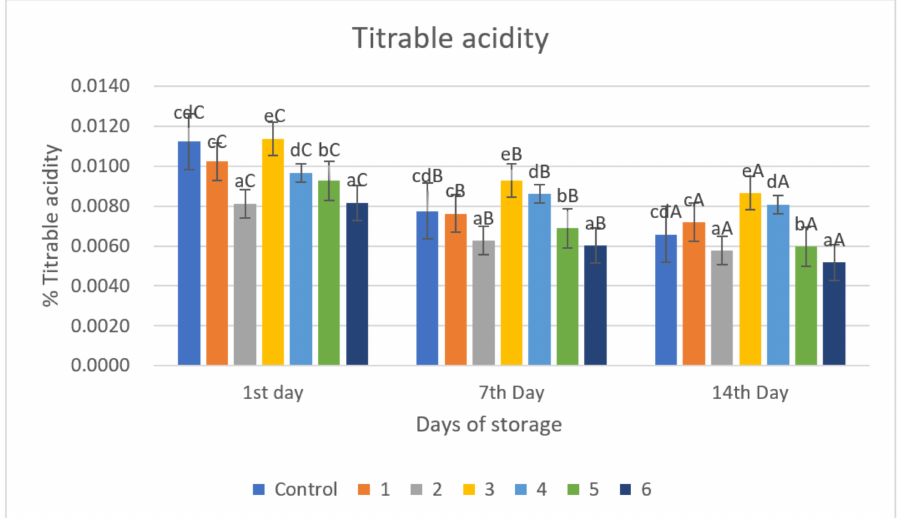
Figure 5. Titrable acidity of red chili during storage. a–e non-capital letters show the difference between the day of storage ( p < 0.05). A–C capital letters show the difference between the day of storage ( p < 0.05). Control: Uncoated Sample; 1: Gelatin75%-Pectin25%-Garlic Essential Oil2%; 2: Gelatin75%-Pectin25%-Garlic Essential Oil Oil3%; 3: Gelatin50%-Pectin50%-Garlic Essential